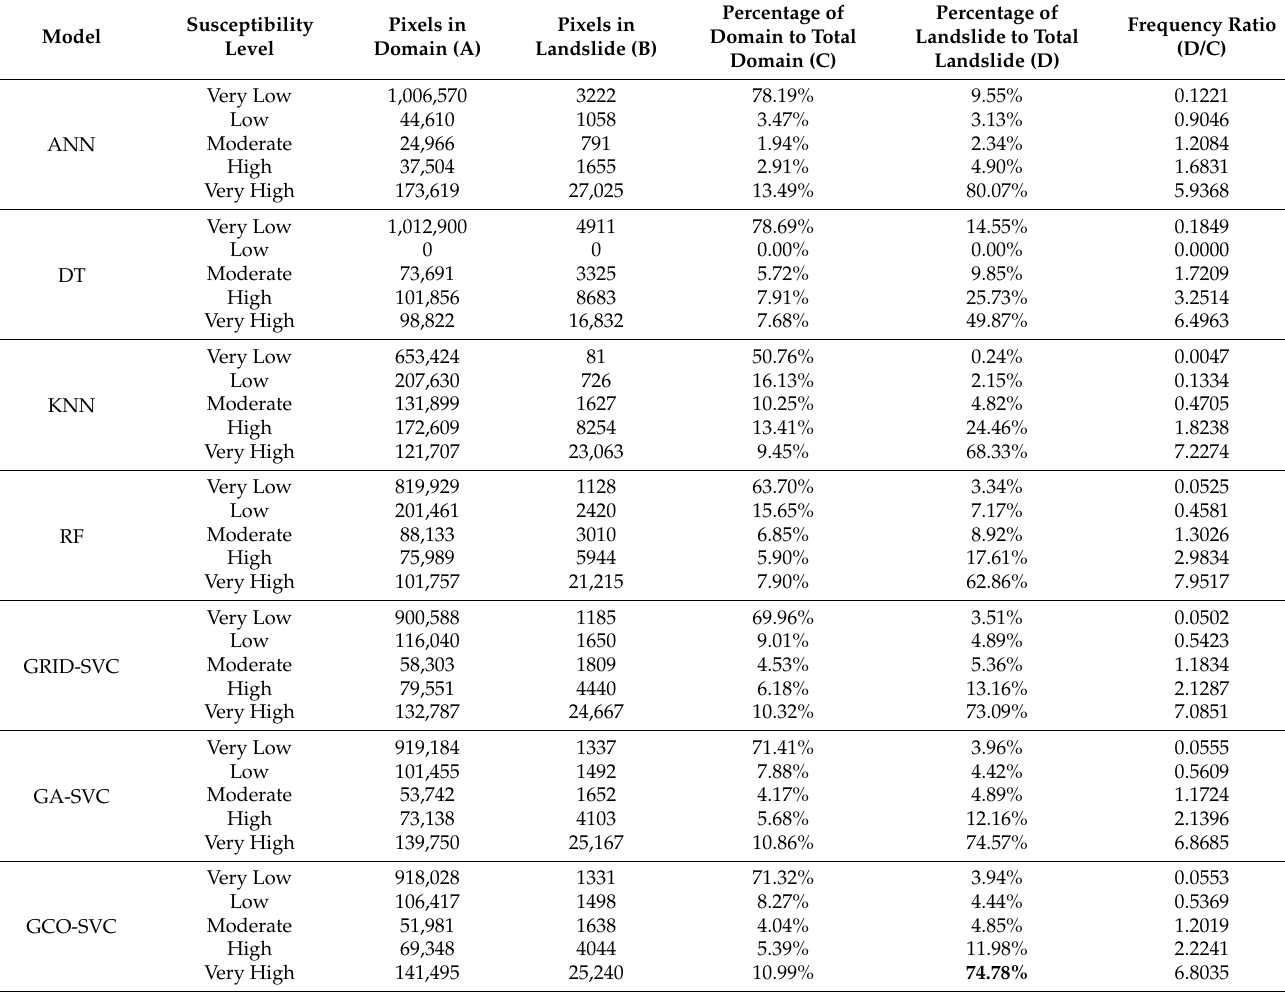
Table 8. Density analysis of landslide susceptibility maps of the different